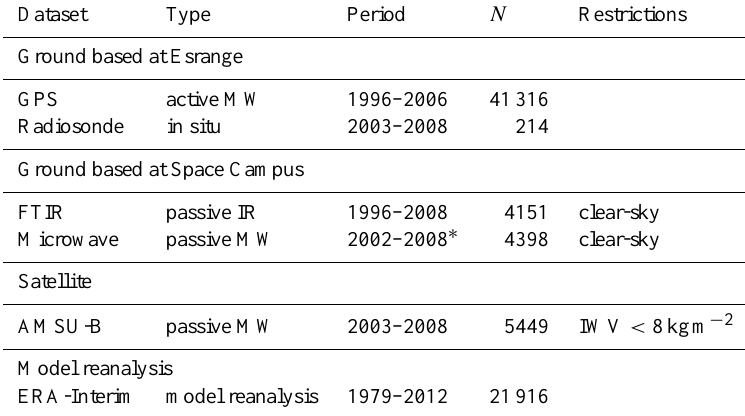
Table 2. Dataset properties. MW = microwave, IR = infrared. The column “Period” shows the time period covered by the dataset in this study. The column “ N ” shows the total number of measurements used in this study. Column “Restrictions” indicates restrictions for the various datasets, which either follow from the instrument descriptions in Sect. 2, or from our study results (Sects. 4 and